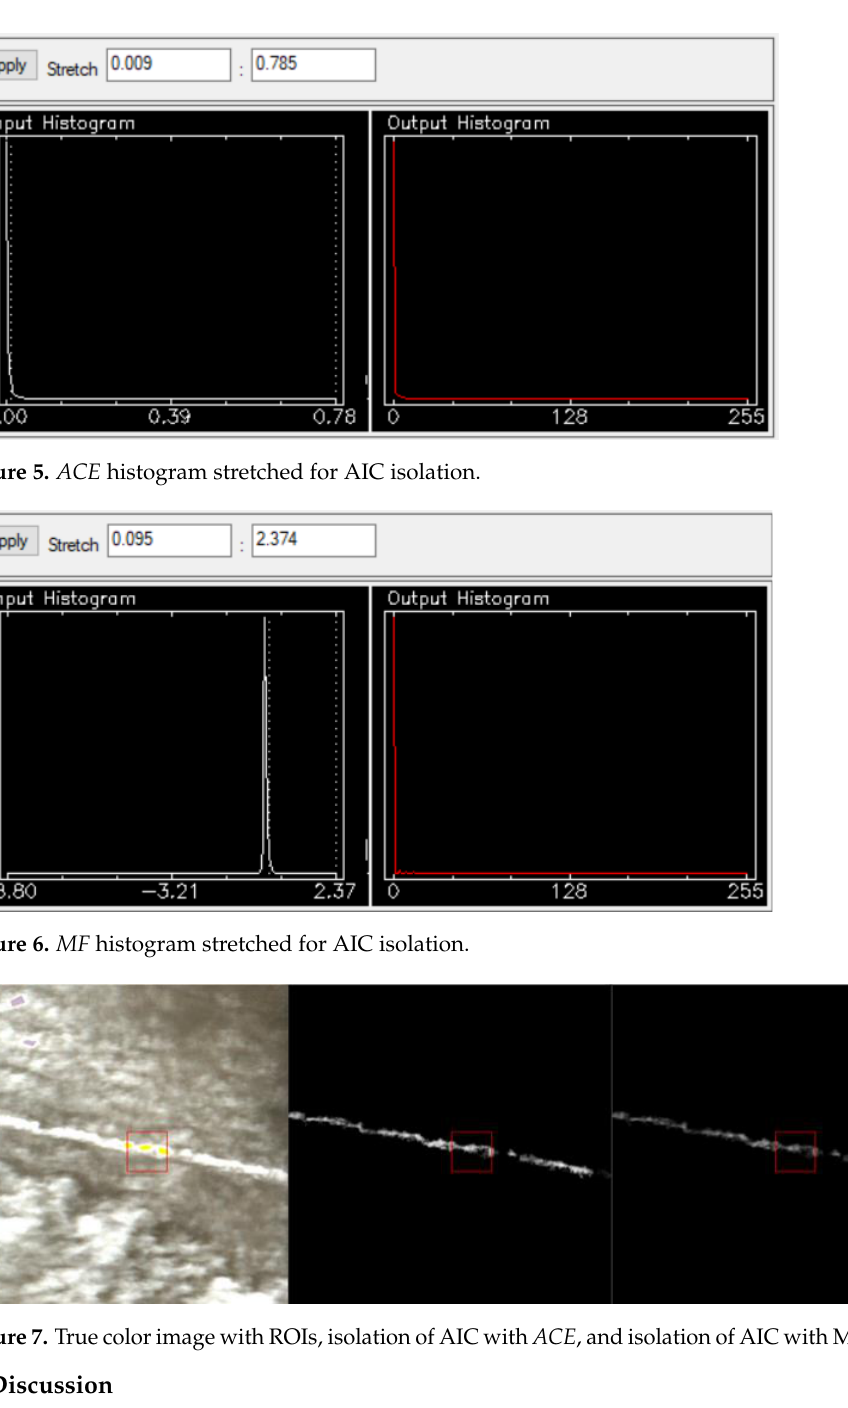
Figure 7. True color image with ROIs, isolation of AIC with ACE , and isolation of AIC with MF